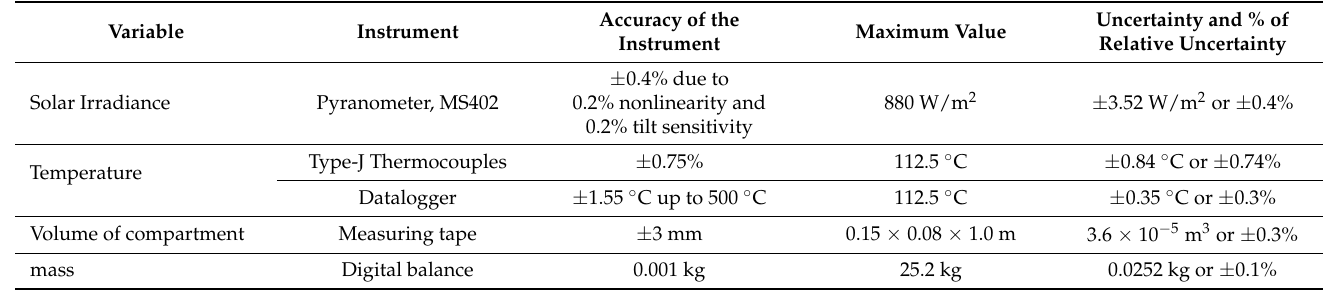
Table 2. The estimated uncertainties of measurement variables due to systematic